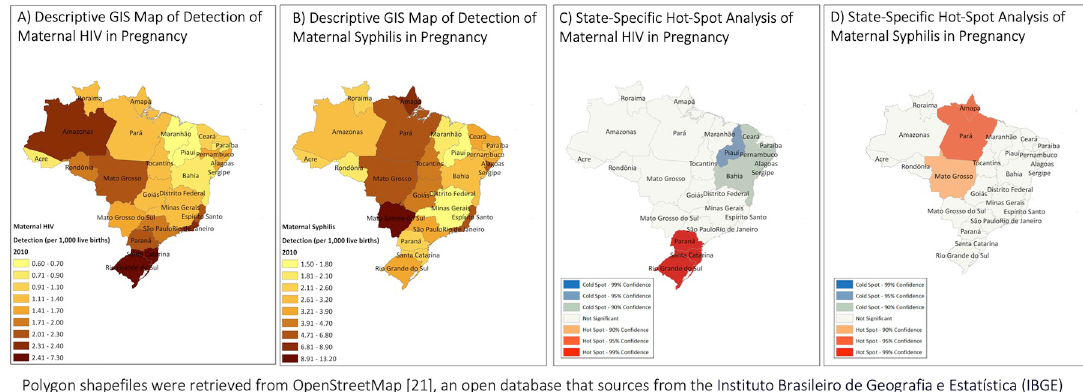
Fig 2. Spatiotemporal maps of the annual rate of detection of maternal HIV and syphilis among pregnant women in Brazil, 2010.